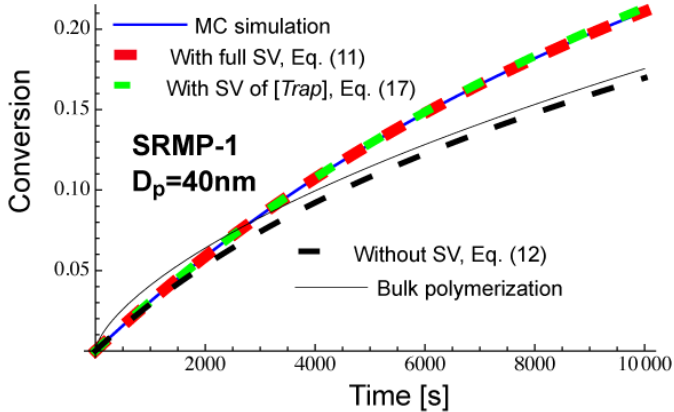
Figure 11. Calculated conversion development of a miniemulsion polymerization with = 40 nm. The parameters used are the same as for Figures 3 and D p